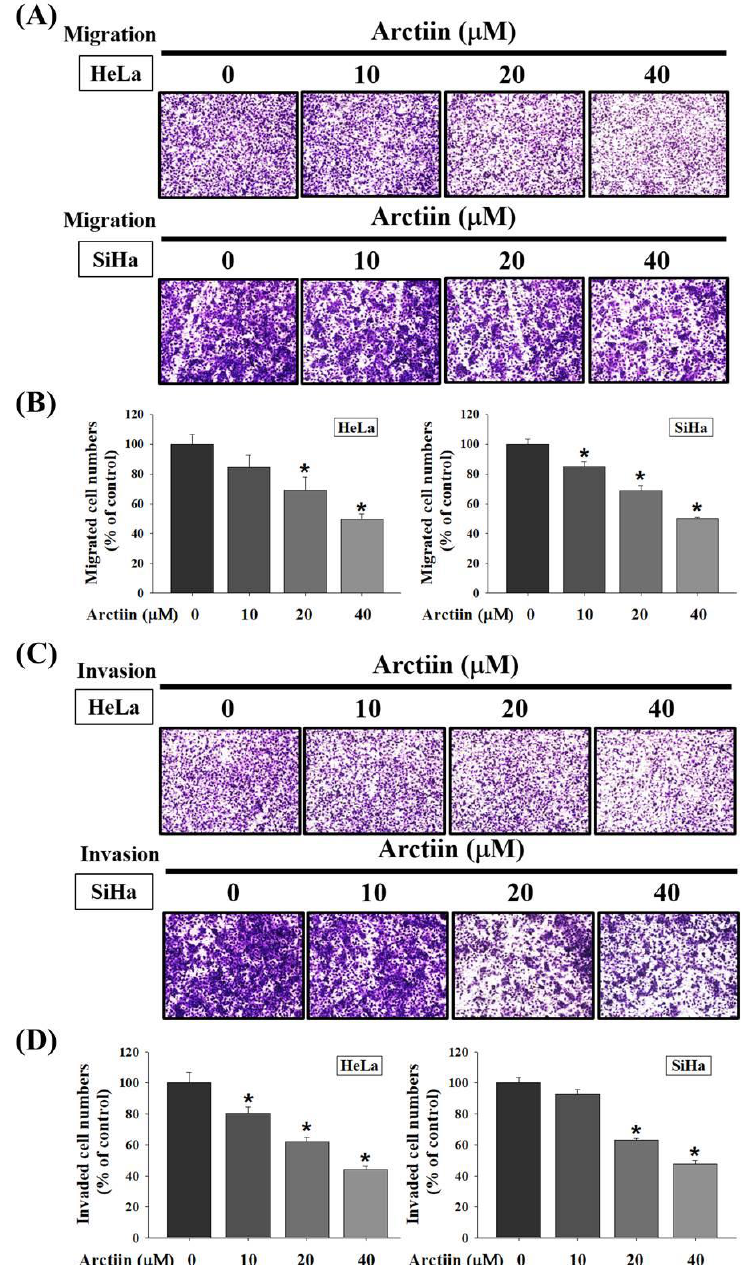
Figure 2. Effects of arctiin on cell migration and invasion of HeLa and SiHa cells. After being treated with arctiin at a concentration of 0, 10, 20, and 40 μM for 24 h, the cell migration and invasion were measured using a Boyden chamber. The number of cells that invaded the underside of the porous polycarbonate was accounted for by assessing the migration ( A , B ) and invasion ( C , D ) abilities of HeLa and SiHa cells. The values represented the means ±SD of at least 3 independent experiments. * p < 0.05, compared with the group that was without arctiin treatment.